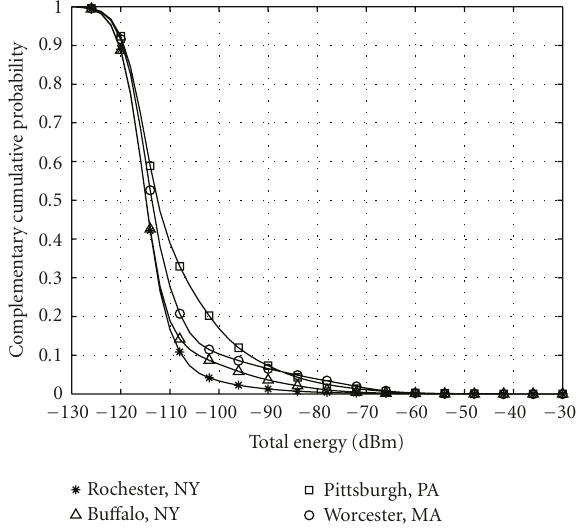
Figure 1: Cumulative distribution functions showing spectrum occupancy for the four cities